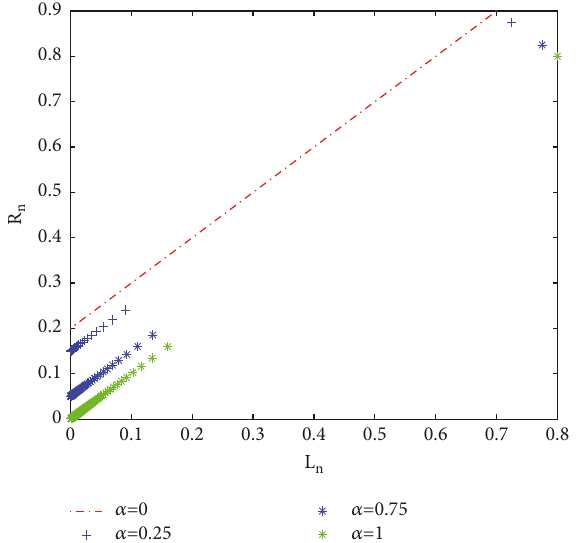
Figure 4: The dynamics of system (54) with initial value 𝑥 0 = (0.7,0.8,0.9) .